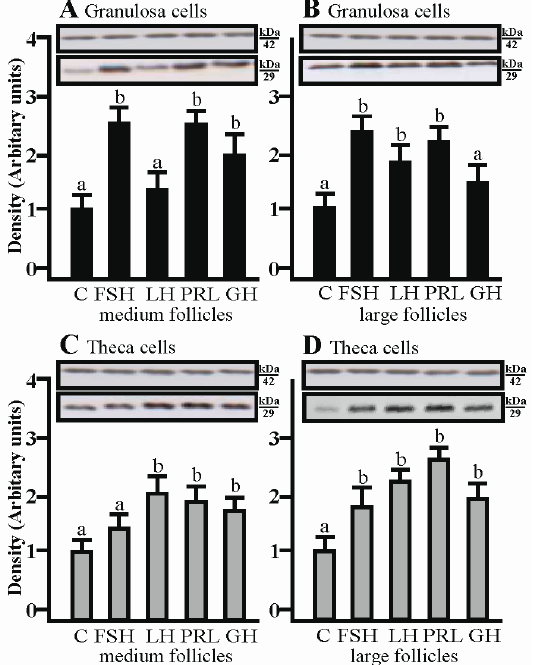
Figure 4. The expression of AQP1 protein in granulosa and theca cells co-cultured in the presence of FSH, LH, PRL, GH in medium and large follicles. ( A , B ) the granulosa cells and theca cells ( C , D ). FSH, follicle-stimulating hormone; LH, luteinizing hormone; PRL, prolactin; GH, growth hormone. Values are expressed as means ± S.E.M from five separate experiments, each performed in triplicates ( p < 0.05 compared with controls). AQP1 protein levels was performed (29 kDa) and normalized against β -actin (42 kDa). Statistically significant differences between treatments are indicated by different letters (a, b). C: control.